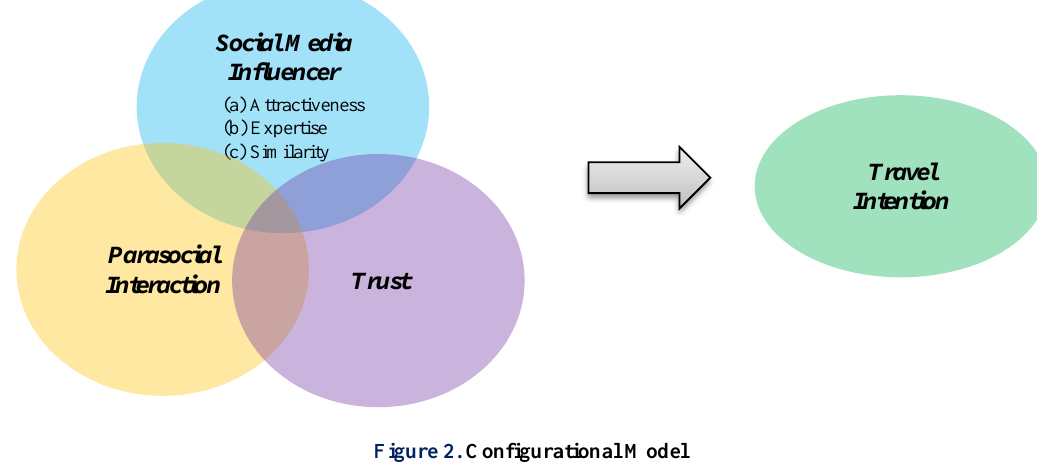
Figure 2. Configurational Model